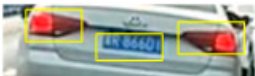
Figure 9. The taillight candidate areas extracted by the gradient feature.